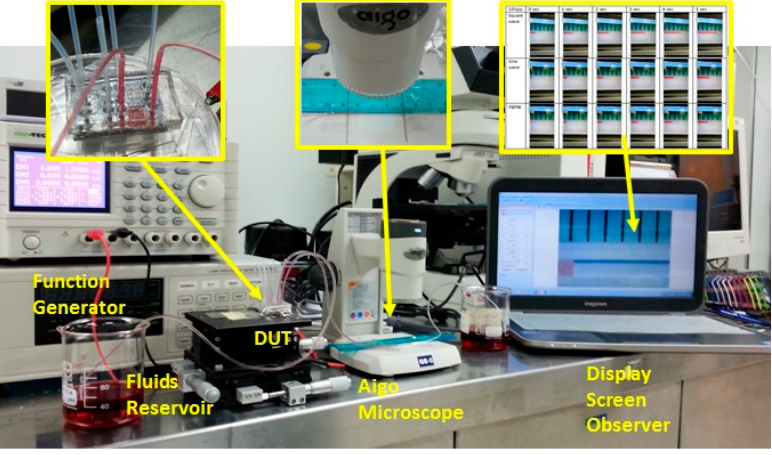
Figure 9. The photograph of the measurement system for the EM micropump test.